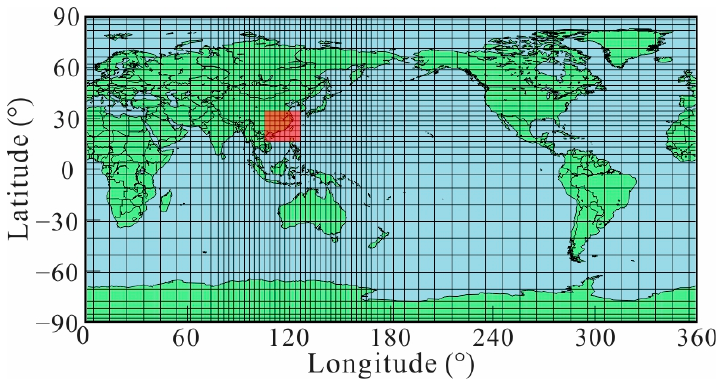
Figure 5. The heterogeneous grid used in our inversion. The red zone is the research area of this paper.